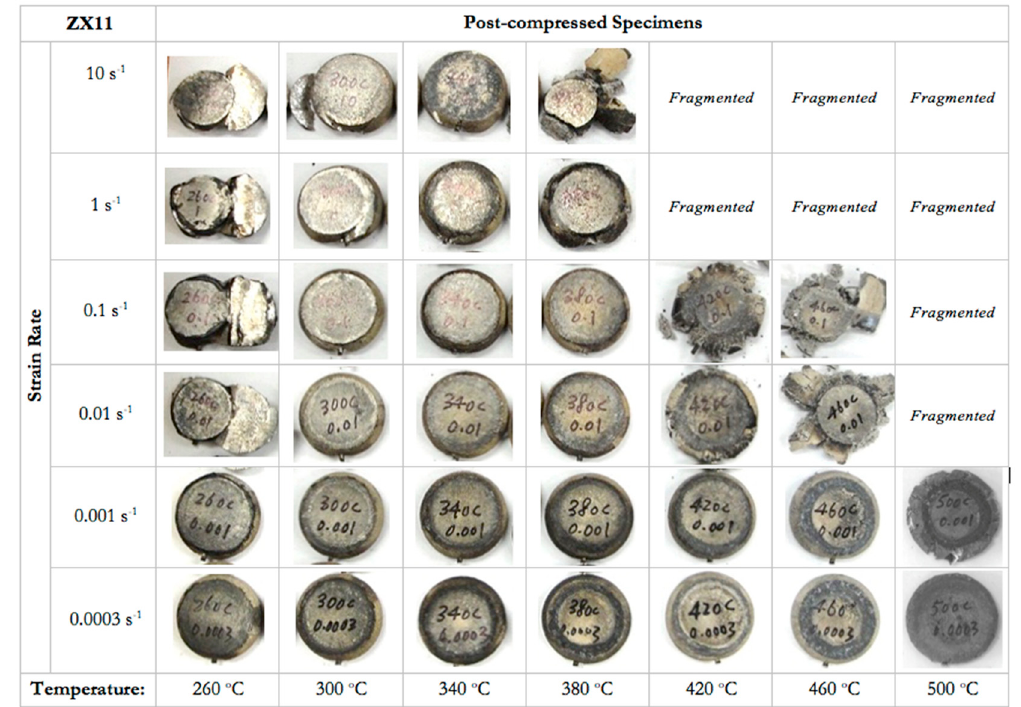
Figure 5. Specimen shapes after compression of ZX11 alloy at different test conditions.